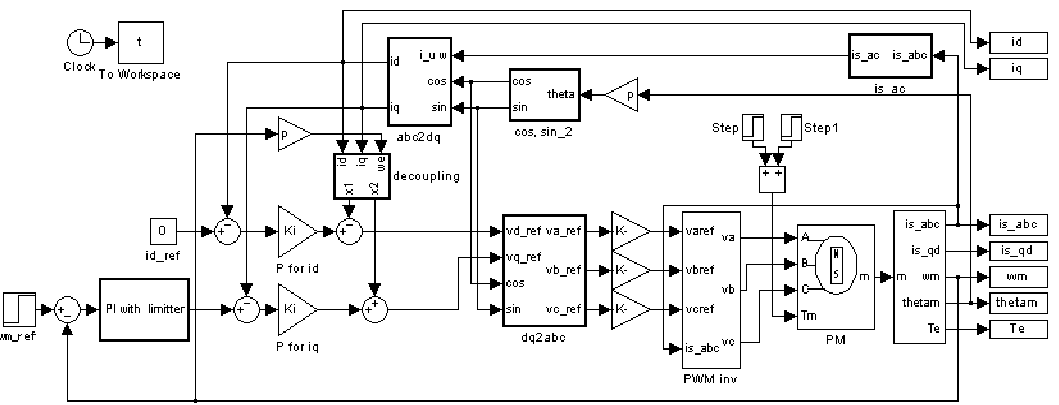
Figure 5. Block diagram for a PMSM under a vector control strategy.